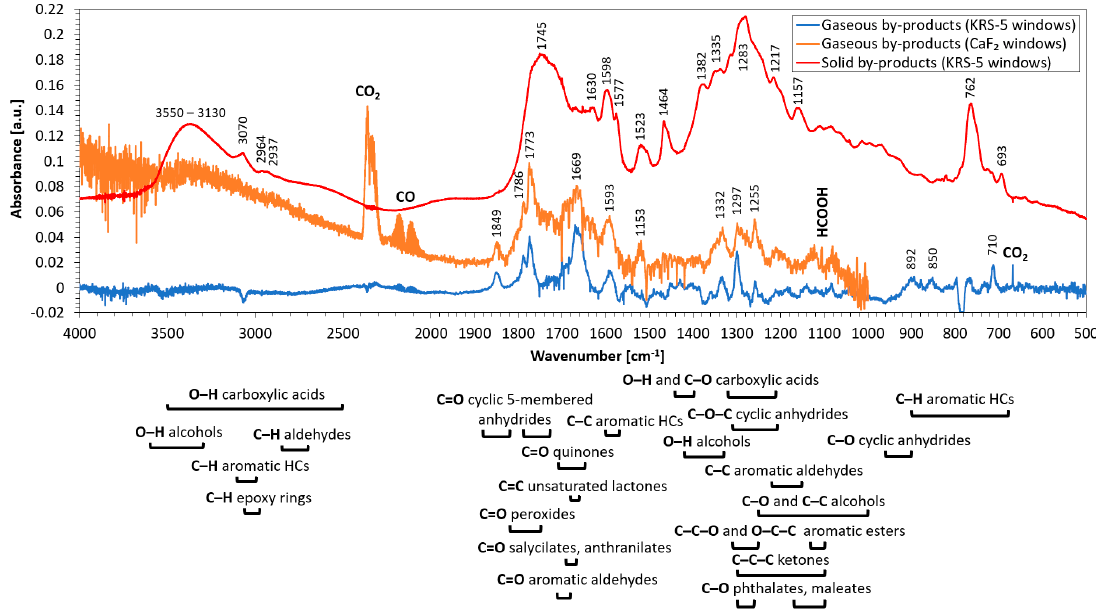
Figure 7. Infrared absorption spectra of gaseous (blue and orange line) and solid (red line) by-products of naphthalene decomposition (HCs = hydrocarbons).